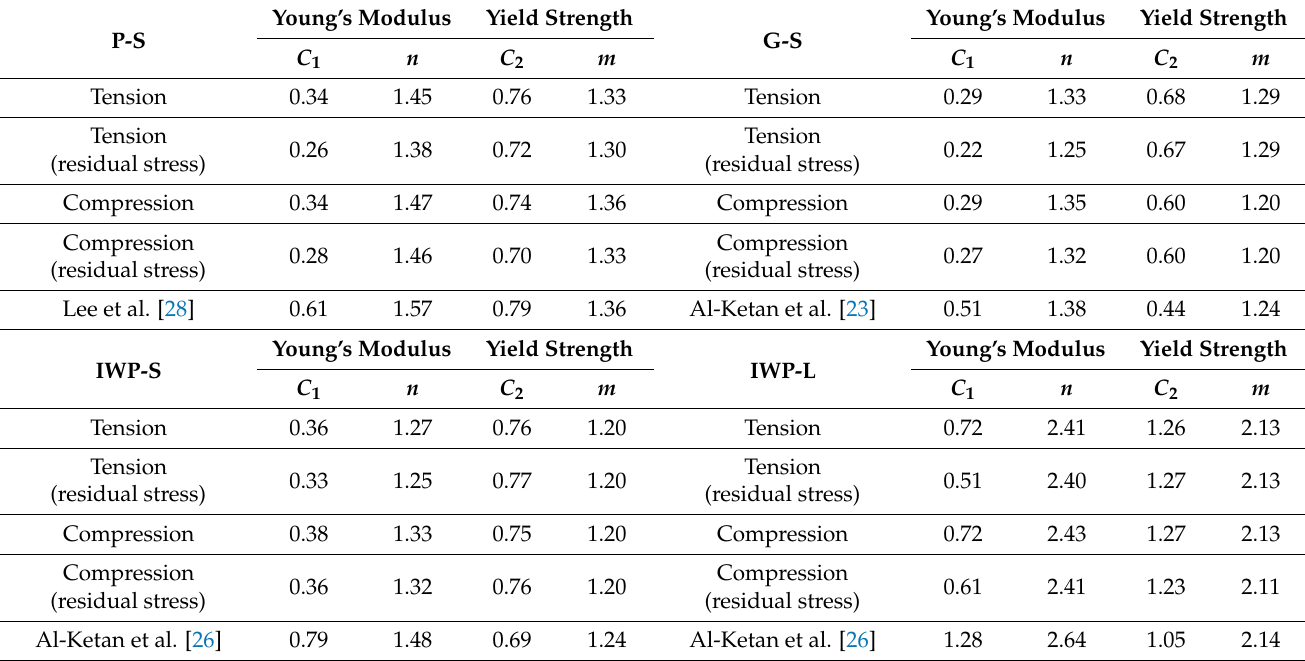
Table 3. Scaling law parameters, normalized young’s modulus, and yield